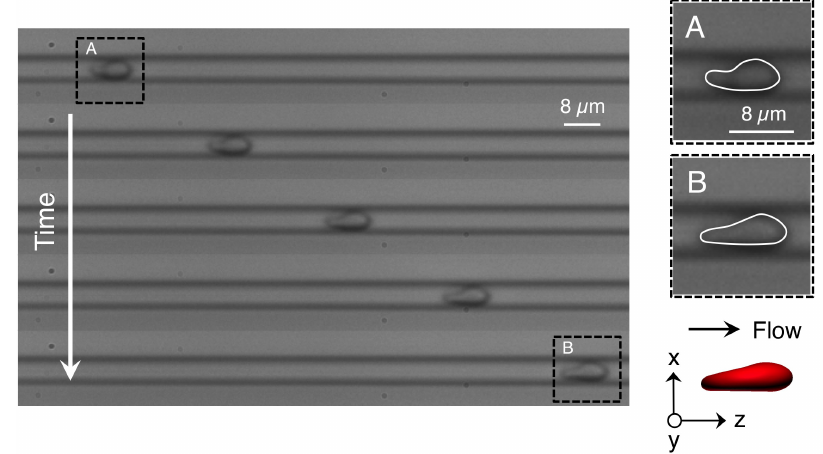
Figure A2. Representative images of the flowing RBC at frame numbers 0 (top), 20, 40 60, and 80 (bottom), respectively, where the speed of the cell is 1200 µ m/s (see also Video S1). A representative numerical result of a stable slipper-shaped RBC subjected to Ca = 0.01 (calculated centroid velocity V c ∼ 25 µ m/s) is also displayed (see also Video